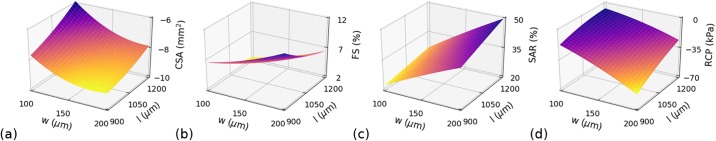
Response surfaces highlighting the combined influence of w and l on each performance metric (CSA, FS, SAR and RCP), holding Ar and t constant at their baseline values (Ar = 1.35 and t = 150 μm).